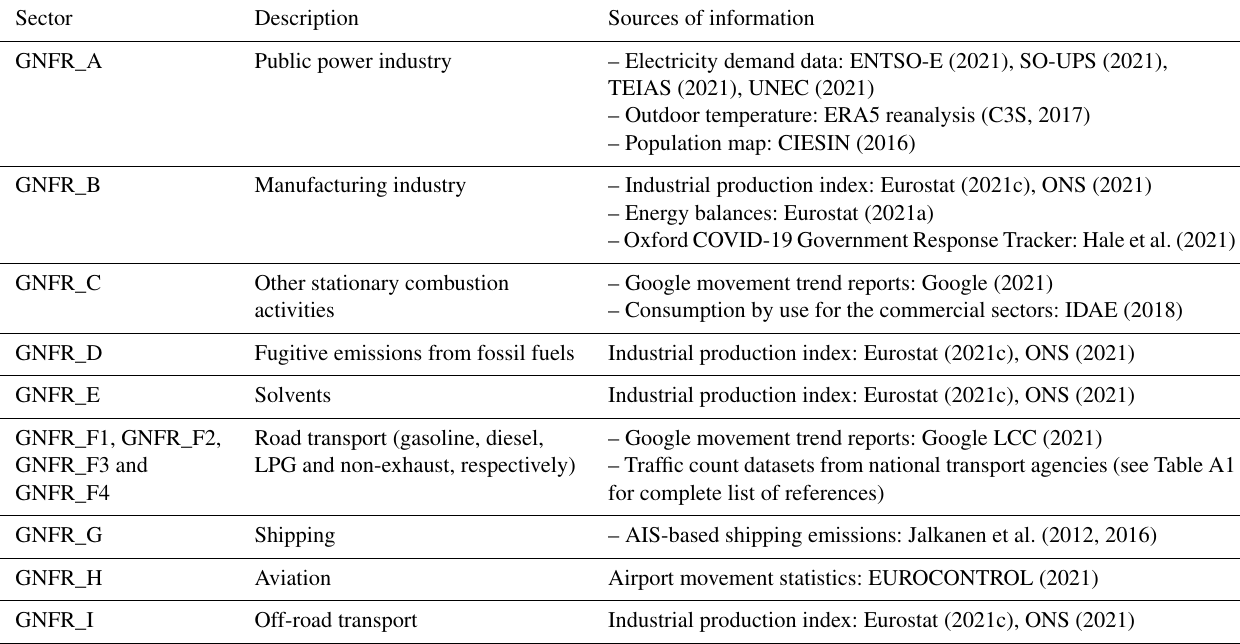
Table 1. Summary of information sources used to compute the emission adjustment factors for each sector. AIS denotes automatic identifi- cation system.